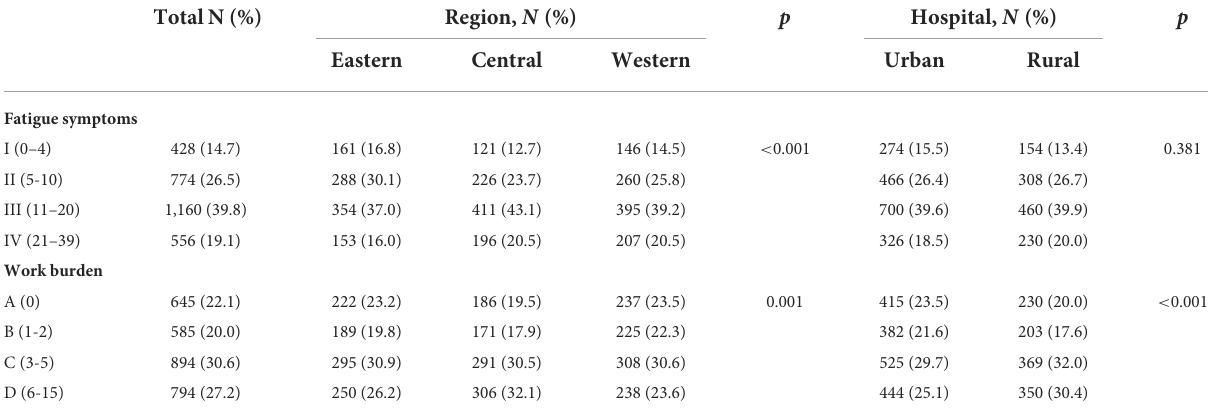
TABLE 3 Fatigue symptoms and work burden reported by respondents ( n =